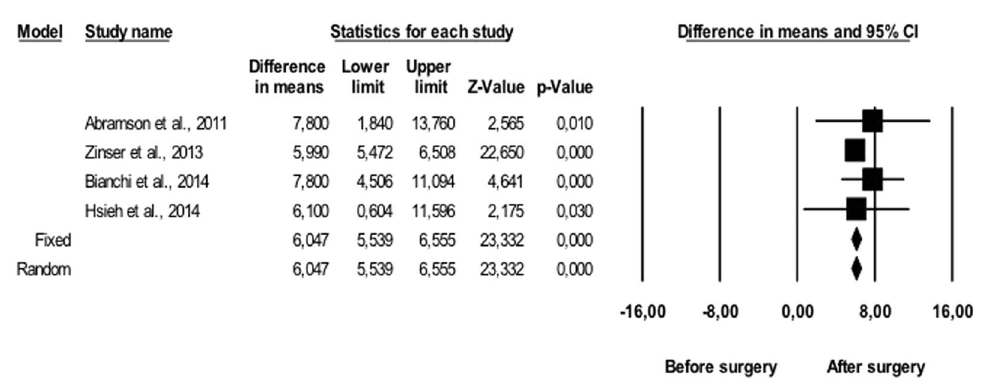
Figure 2. Changes in UA, supine position (mm 3 ). Enlargement of upper airway following bimaxillary advancement surgery. Meta-analysis.